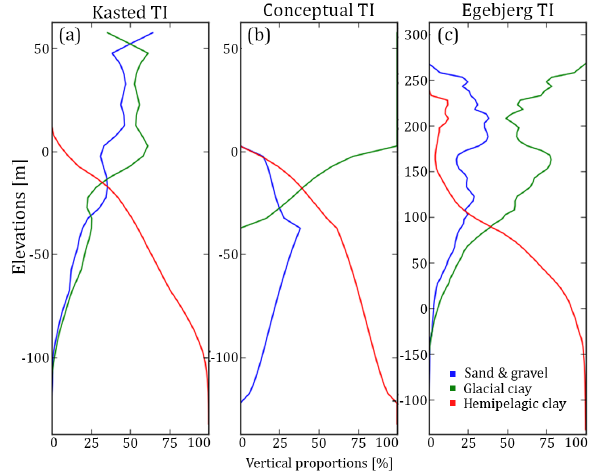
Figure 5. The vertical proportions of the three training images for each of the hydrostratigraphic categories, where (a) portrays the Kasted TI, (b) the conceptual TI, and (c) the Egebjerg